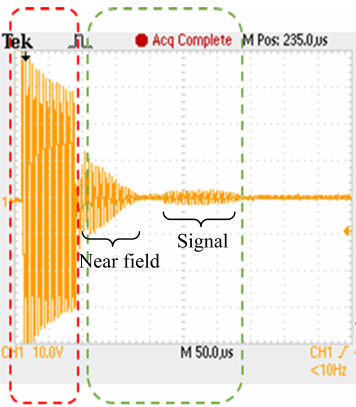
Figure 7. The ping and echo signals from SFBE recorded by an oscilloscope.